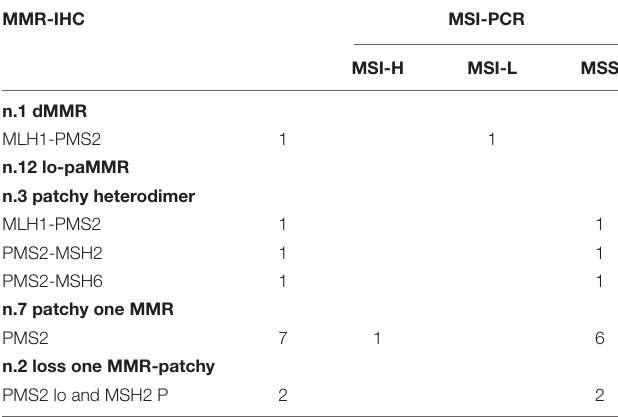
TABLE 3 | Comparison of the results of MMR-IHC analysis and MSI-PCR